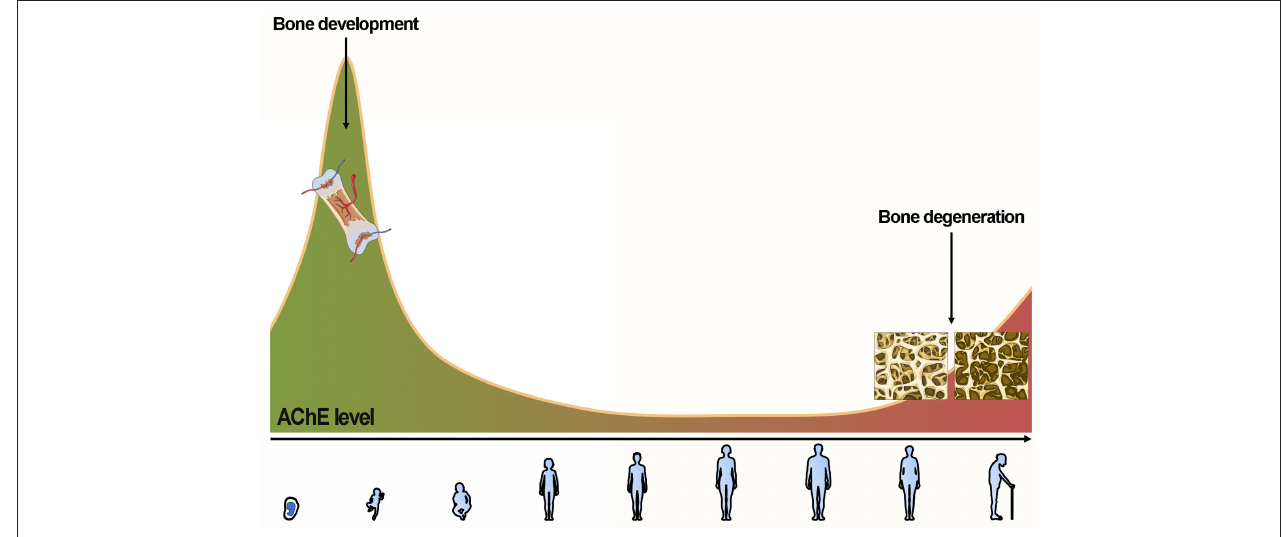
FIGURE 3 | AChE first increases to favor chondrocyte remodeling to osteoblasts and gradually decreases and maintains a low level for a long time. AChE paradoxically increases after menopause or remains unchanged with aging. The (relative) increase of AChE contributes to age-related bone